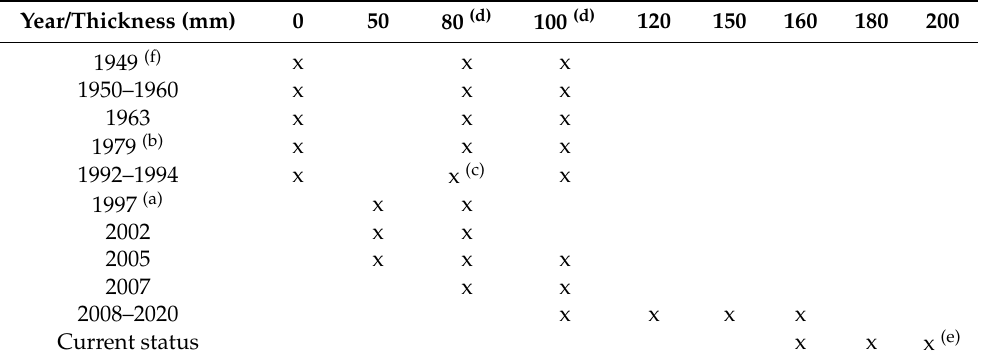
Table 3. Development of thermal insulation thickness in accordance with the development of thermal protection standard (Czech Code 73 0540 and EPBD (I, II, III)), in comparison with Table